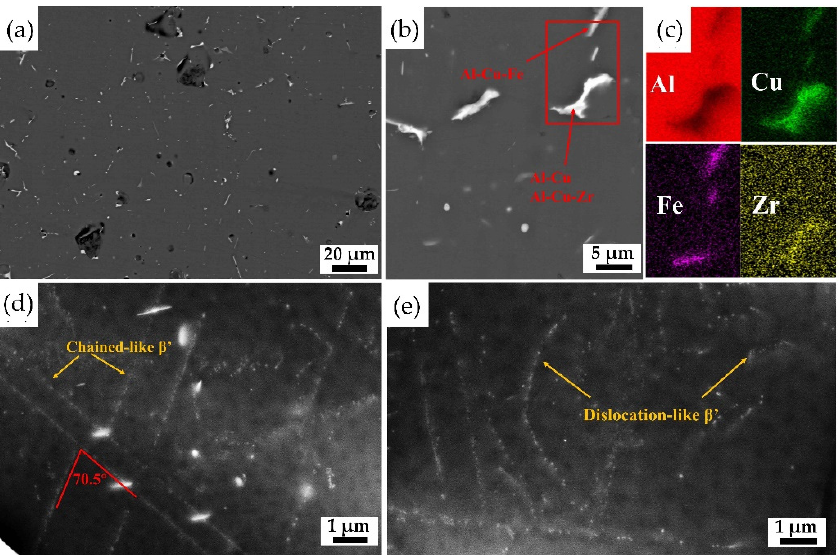
Figure 3. ( a ) SEM micrographafter homogenization of P1; ( b ) and ( c ) high magnification SEM image, and corresponding EDS scan composition mappings; ( d ) and ( e ) SEM micrographs of the intracrystalline region of the alloy in the two-stage homogenized state (thin region).